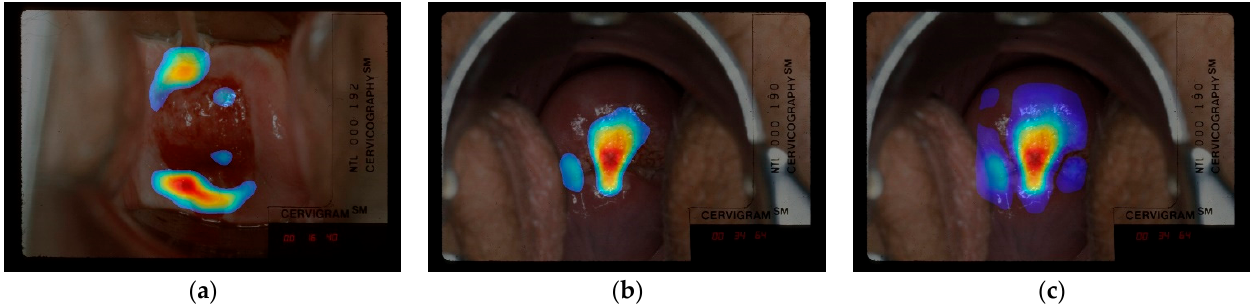
Figure 6. ( a ) CRM visualization, which is considered as “highlighted area out of the region of interest”. ( b ) CRM visualization, which is considered as “insufficient coverage of region of interest”. ( c ) Sample of CRM visualization with a lower threshold of 15% of the maximum score on the same image with ( b ).